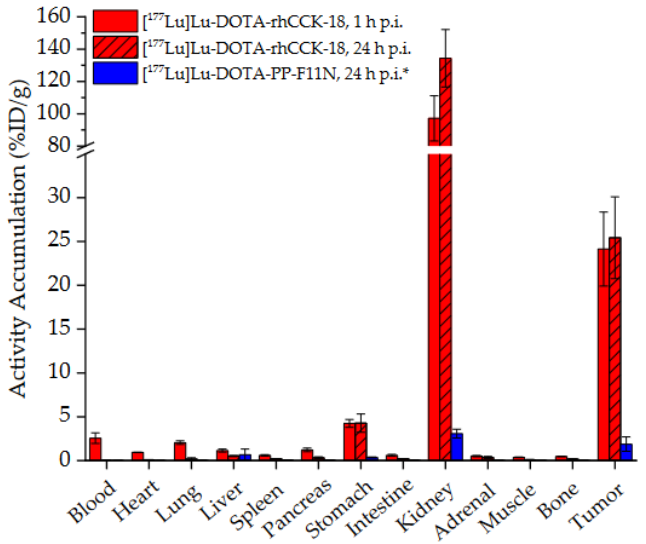
Figure 4. Biodistribution of [ 177 Lu]Lu-DOTA-rhCCK-18 in selected organs (%ID/g) at 1 and 24 h p.i. in comparison to [ 177 Lu]Lu-DOTA-PP-F11N at 24 h p.i. in AR42J tumor-bearing CB17-SCID mice (100 pmol each). Data is expressed as mean ± SD ( n = 4). * data taken from Holzleitner et al. [19]. These data have been determined in our lab under identical conditions.